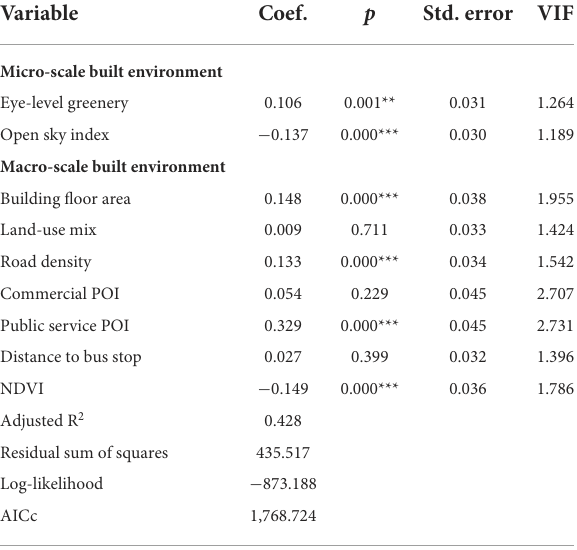
TABLE 3 Results of ordinary least squares (OLS) model of built environment and e-bike (fishnet = 600 × 600m, N =